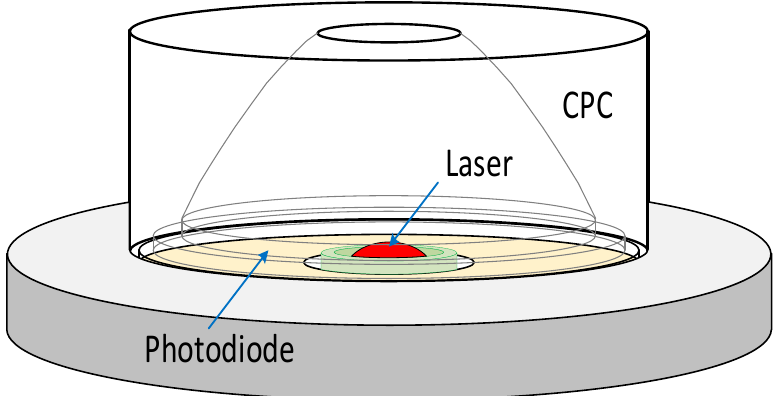
Figure 6. The schematic of the particle counter based on CPC. Adapted with permission from ref. [68]. © 2021 IEEE.